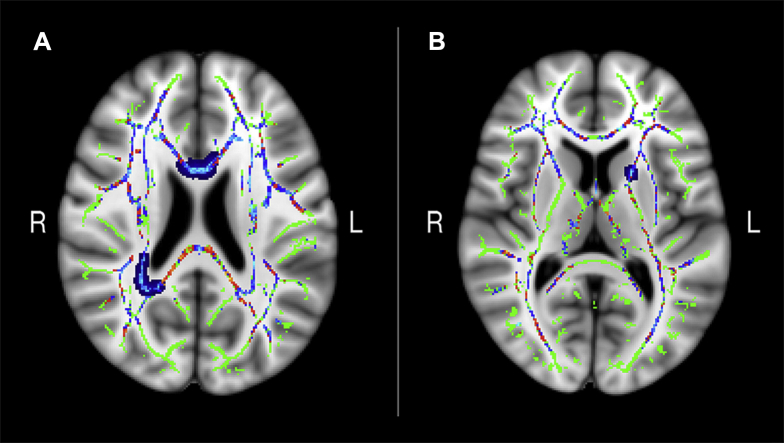
WM integrity and memory performance—general versus specific effects. (A) Cluster 1 and cluster 2 shown in blue. Axial view of Talairach coordinates x = 90, y = 137, and z = 94. (B) Cluster 3 shown in blue, axial view of Talairach coordinates x = 109, y = 136, and z = 82. The clusters are overlaid on the standard MNI152 T1 1-mm3 brain template and shown on top of the t-statistics to illustrate general effects below the significance threshold (p < 0.05). The blue–lighter blue color map represents areas showing a negative relationship between MD and memory improvement. Lighter blue represents t-values closer to the significant level (p < 0.05, t > 2.2). Areas showing a positive relationship between MD and memory improvement is shown in a red-yellow color map where yellow represents t-values closer to the significant level (p < 0.05, t > 2.2). Abbreviations: MD, mean diffusivity; WM, white matter.